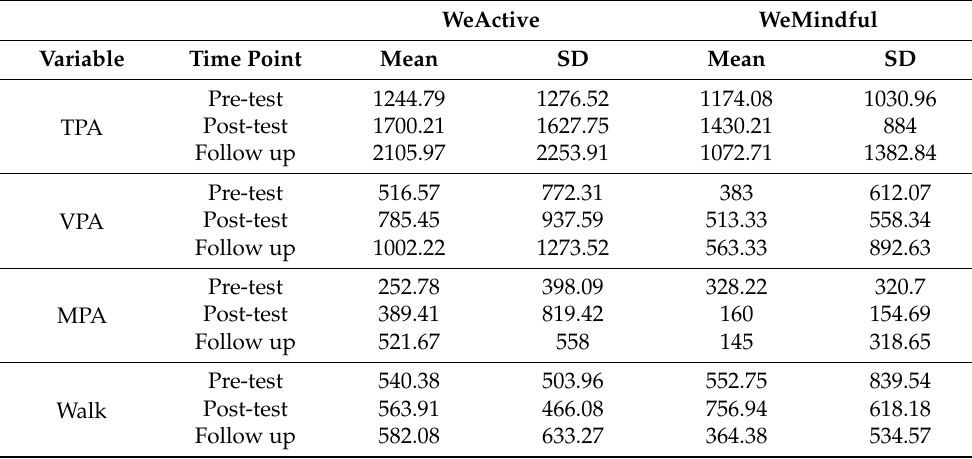
Table 2. Descriptive statistics of PA by group at pre-test, post-test, and follow